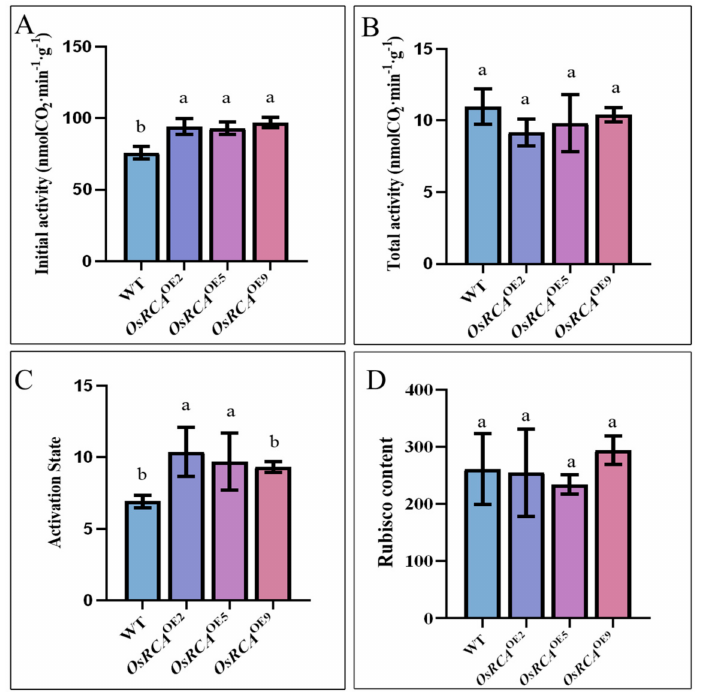
Figure 2. Rubisco activity and content in WT and OsRCA OE lines during maize grain filling. ( A ) Initial Rubisco activity. ( B ) Total Rubisco activity. ( C ) Rubisco activation state; the formula is initial Rubisco activity/total Rubisco activity. ( D ) Rubisco content by ELISA. The LSD test was used for multiple data comparisons. The different letters indicate significant differences at p <